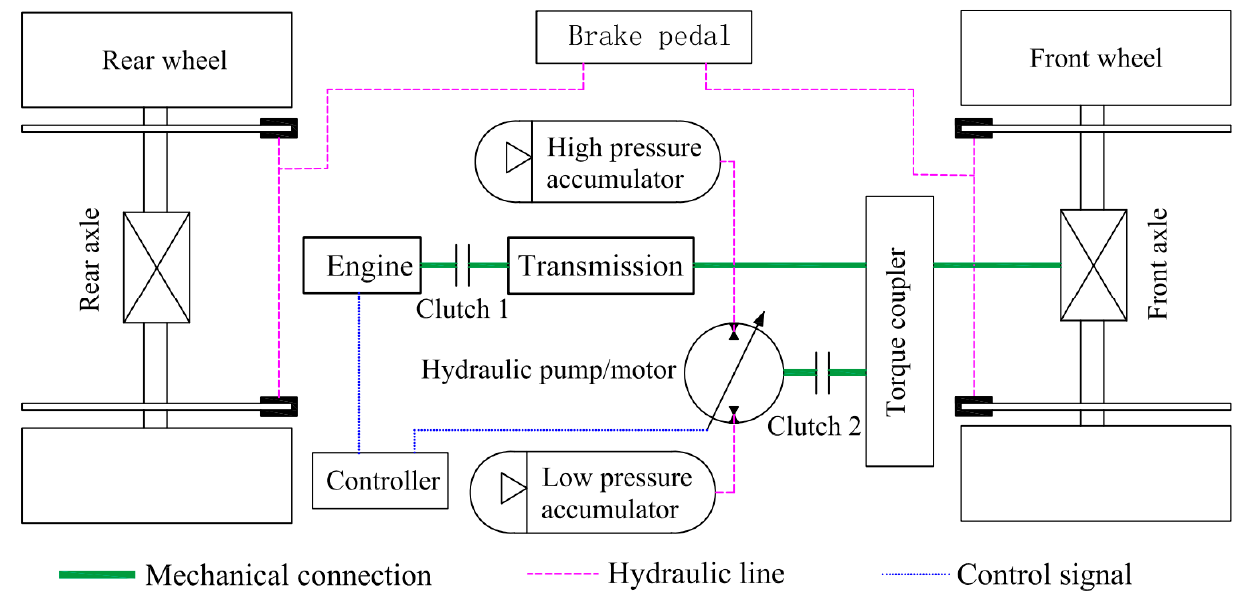
Figure 1. The working principle of HRBS.